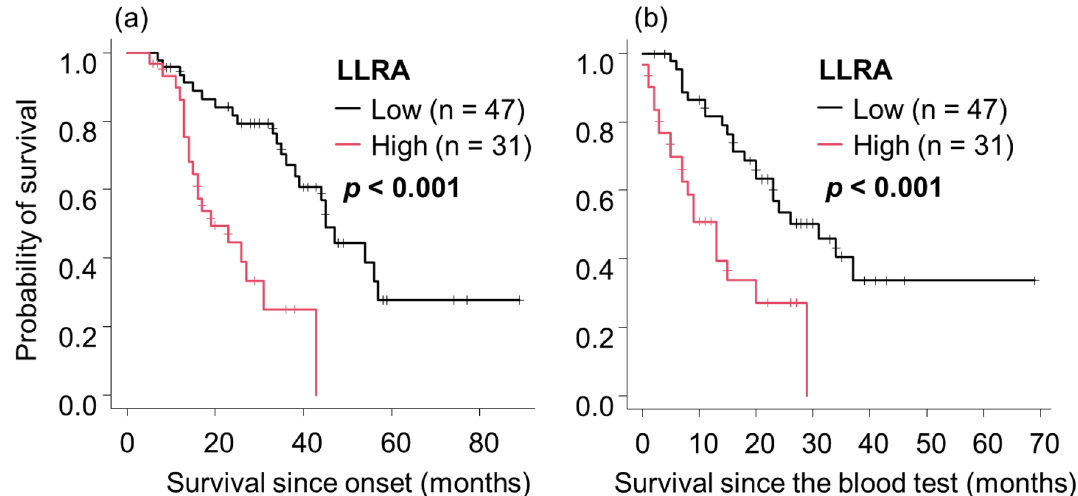
Figure 3. The survival of patients stratified by LLRA. Kaplan–Meier analyses and log-rank tests revealed that patients with high LLRA had significantly shorter survival since onset and since the blood test than patients with low LLRA ( a , b ). Abbreviations: ALS, amyotrophic lateral sclerosis; LLRA, lipid-linked risk for